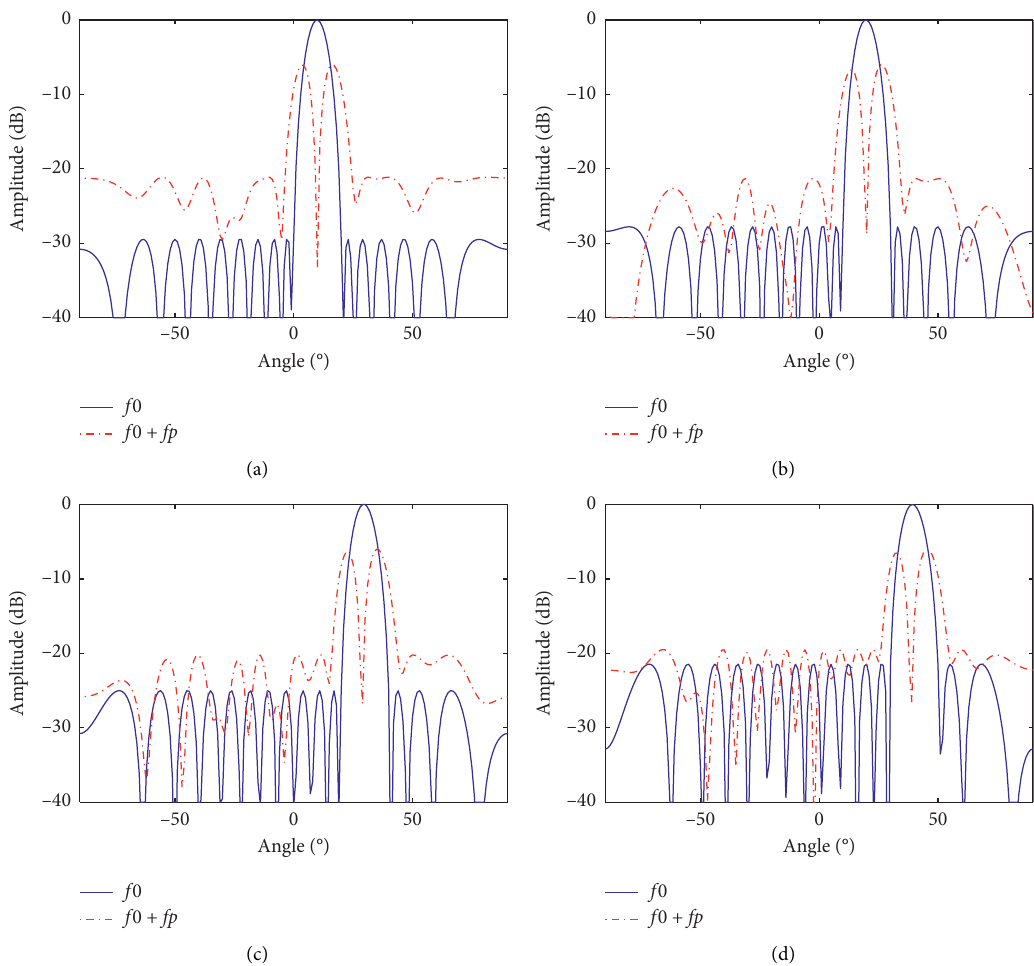
� 10, (b) θ � 20, (c) θ � 30, and (d) θ M M M M